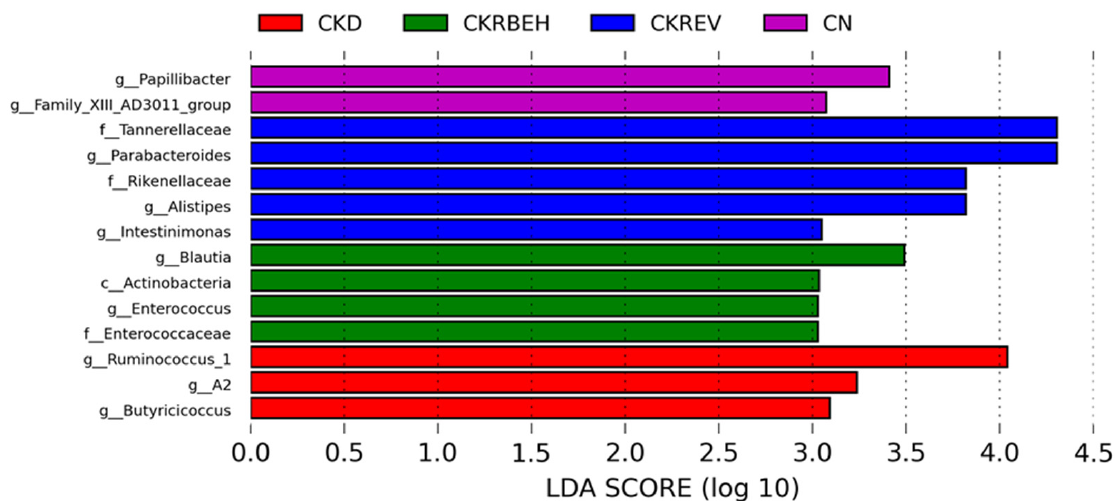
Figure 7. Linear discriminant analysis effect size (LEfSe) was assessed for biomarker discovery. The most enriched bacterial taxa in the CKD (red), CKRBEH (green), CKREV (blue), and CN groups (purple) are shown.